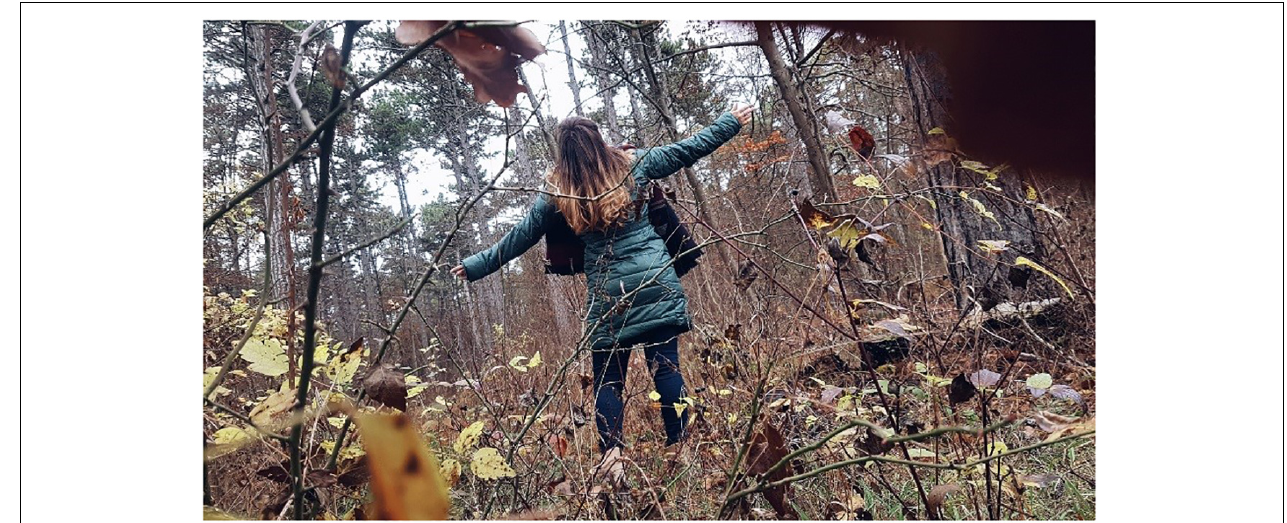
FIGURE 8 | Embracing the world in the forest (source: Instagram/@kamigoesaroundtheworld).